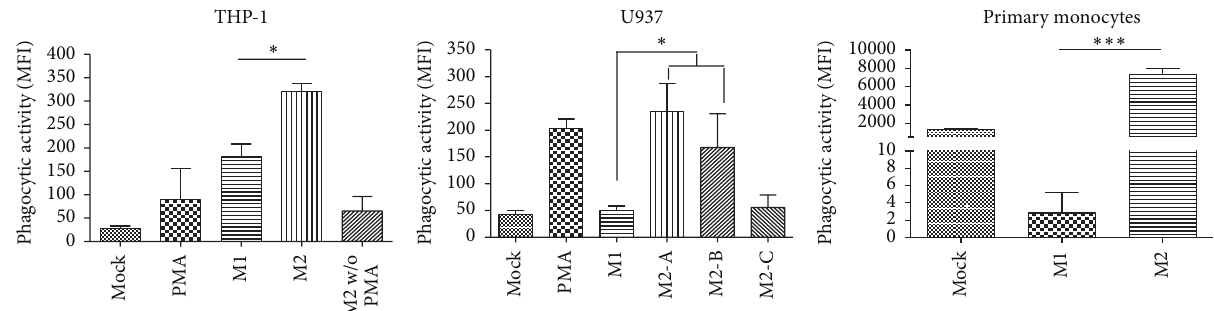
Figure 4: Determination of phagocytosis. Phagocytic activity of THP-1, U937, and primary monocytes expressed as the median fluorescence intensity of fluorescein-labeled E. coli K-12 BioParticles engulfed by cells. Mean of three independent experiments is shown. For THP-1, mock: no stimulated cells; PMA: PMA-only control; M1: PMA + LPS + INF- 𝛾 ; M2: PMA + IL-4 + IL-13; and M2 w/o PMA: IL-4 + IL-13. For U937, mock: no stimulated cells; PMA: PMA-only control; M1: PMA + LPS + INF- 𝛾 ; M2-A: PMA + IL-4 + IL-13; M2-B: PMA + M-CSF; and M2-C: IL-4 + IL-13. For primary monocytes, mock: no stimulated cells; M1: GM-CSF + LPS + INF- 𝛾 ; and M2: M-CSF + IL-4 + IL-13. Asterisks and bars denote statistical significance between conditions. Significance ≤ 0.05 was indicated with ∗ , and ≤ 0.0005 was indicated with ∗∗∗ . In THP-1 cells and primary monocytes there was statistically significant differences between M1 and M2 conditions and in U937 between M1 and M2-A and